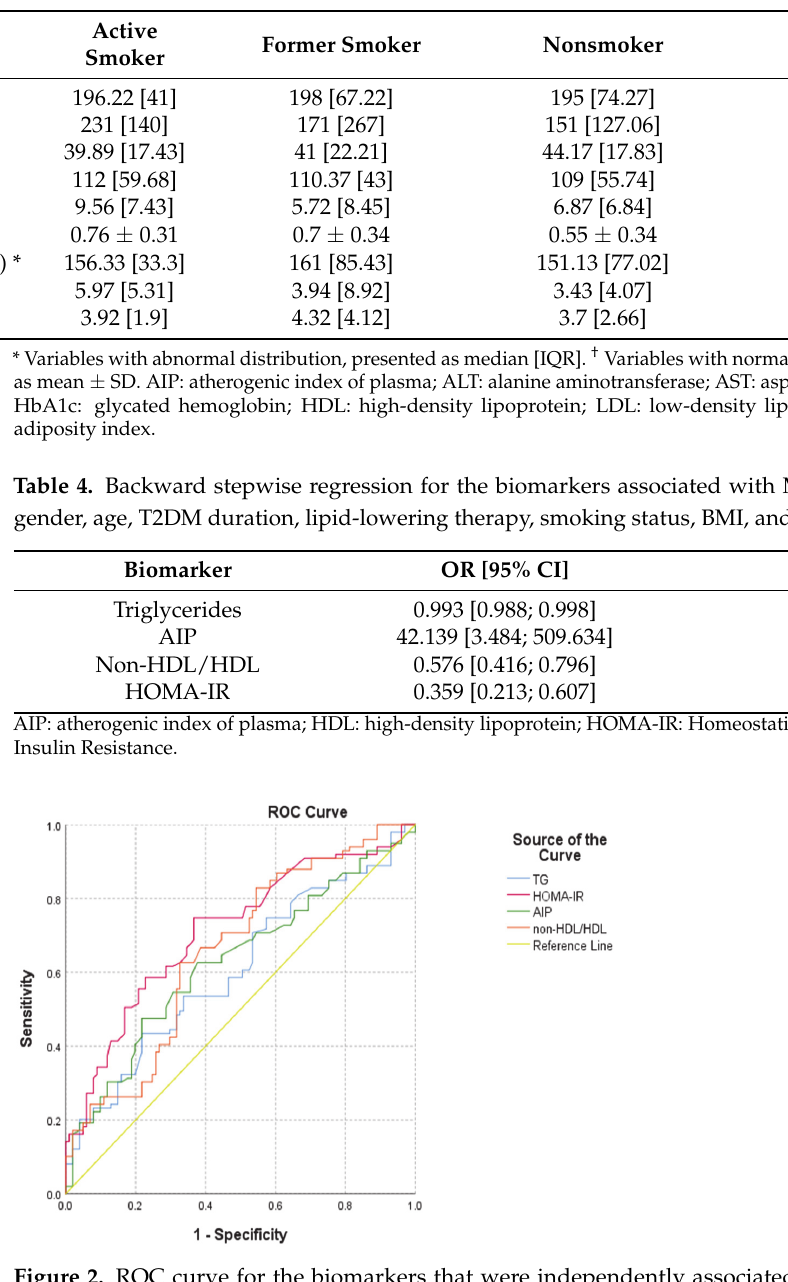
Table 3. Lipid biomarkers associated with the smoking status.